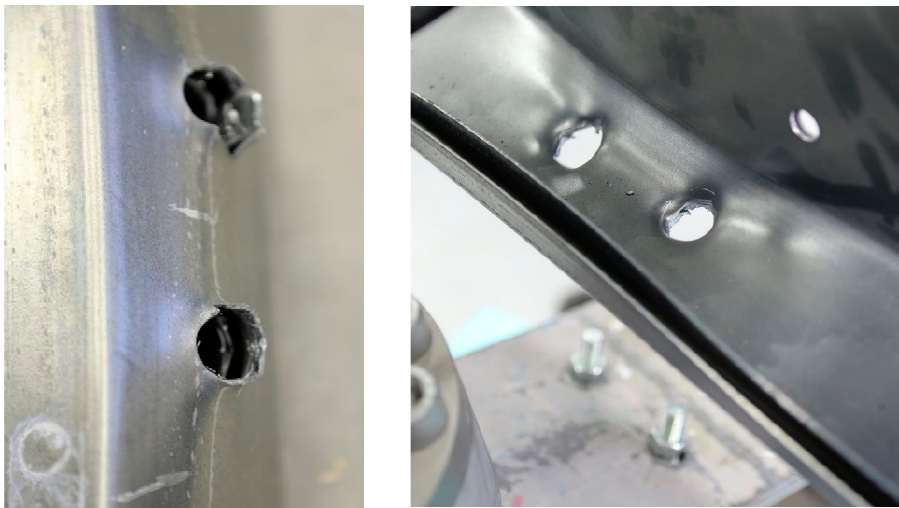
Figure 8. Photographs of pushed bolt heads with flanges Z profiles, 1.89 mm.